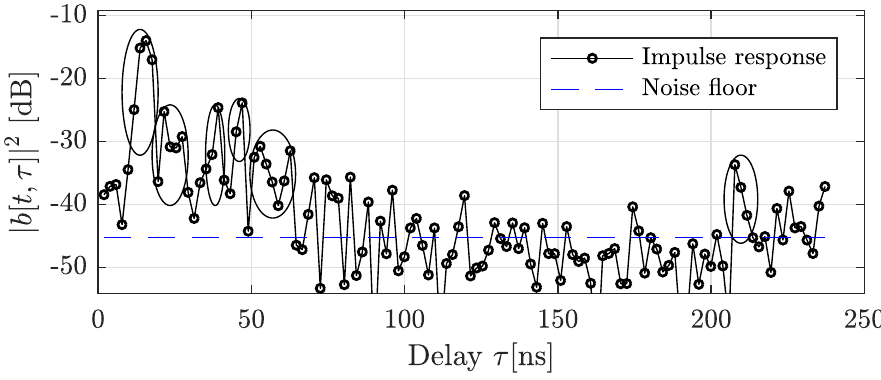
Figure 2. Example impulse response snapshot from measurements. The strong components clearly arrive in clusters. Potential clusters are indicated with ellipses. The noise floor is estimated via the median